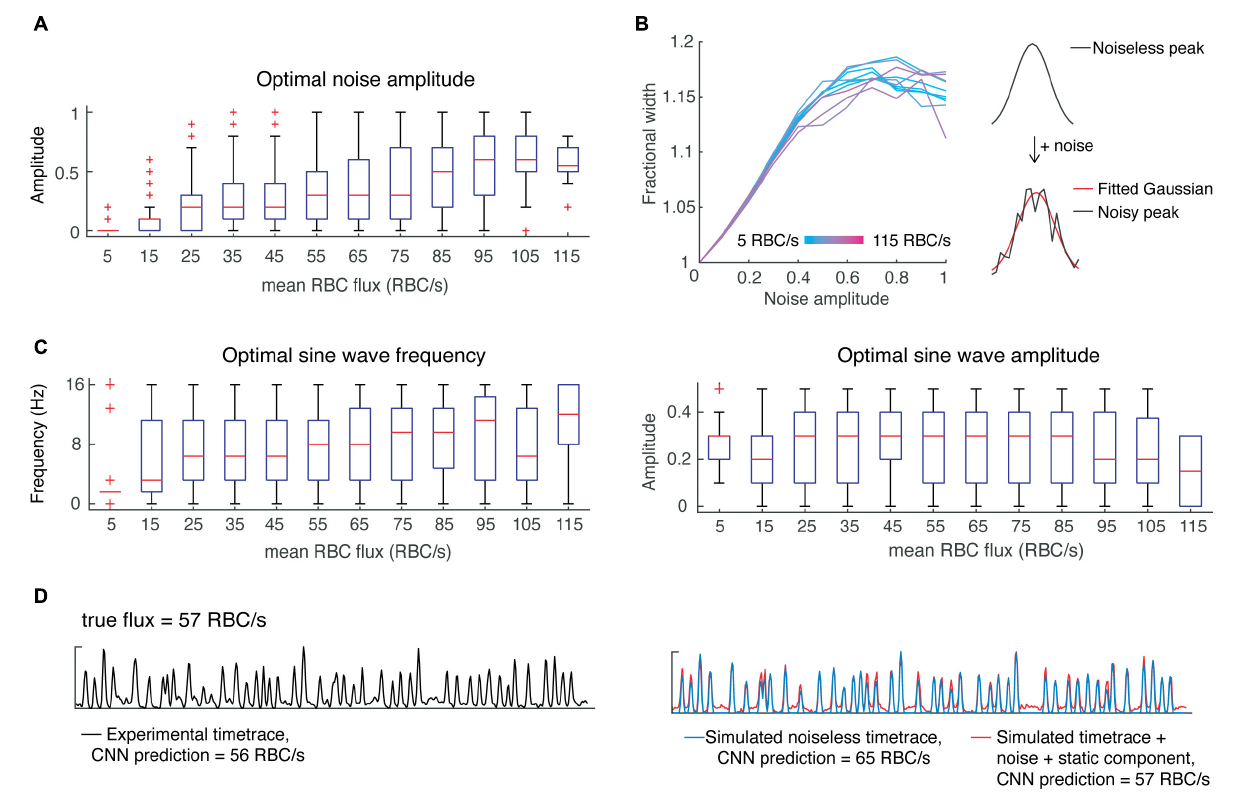
FIGURE 3 | Incorporating noise and a slow-varying component improves predictions of CNN on simulated data. (A) Optimal noise amplitudes to maximize CNN prediction accuracy as a function of flux. (B) Including noise has the effect of increasing peak width as a function of the noise amplitude, reaching a plateau at around 17%. (C) Low flux value time-traces are predicted with greater accuracy when including a slowly-varying component with low frequency, whereas all other flux values show greater variability in the optimal parameters of the slow-varying component. (D) An example showing how incorporating noise and a slow-varying component results in more accurate CNN